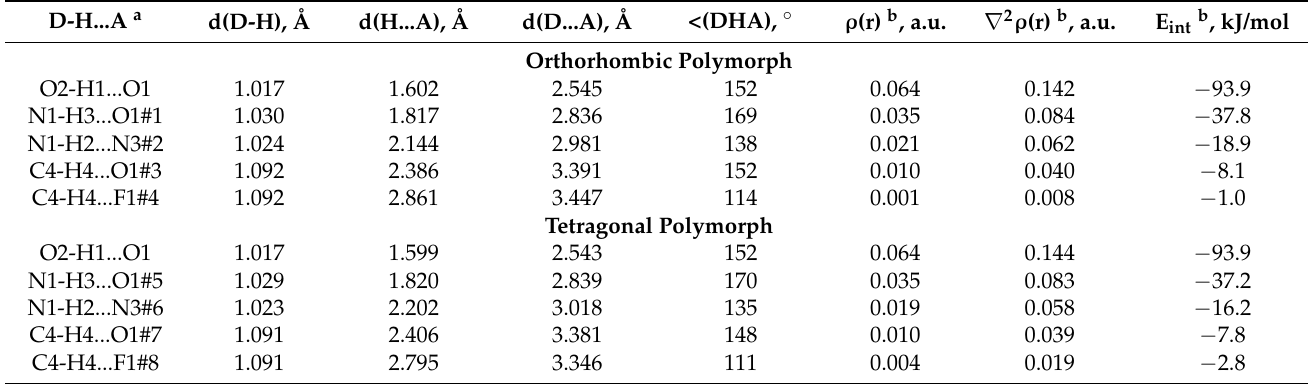
Table 3. Hydrogen bonds for optimized polymorphs of